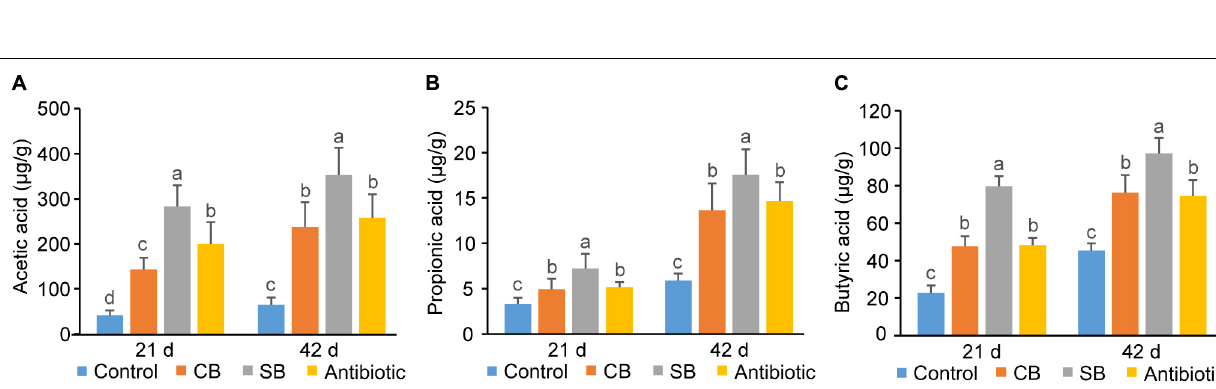
Frontiers in Microbiology |